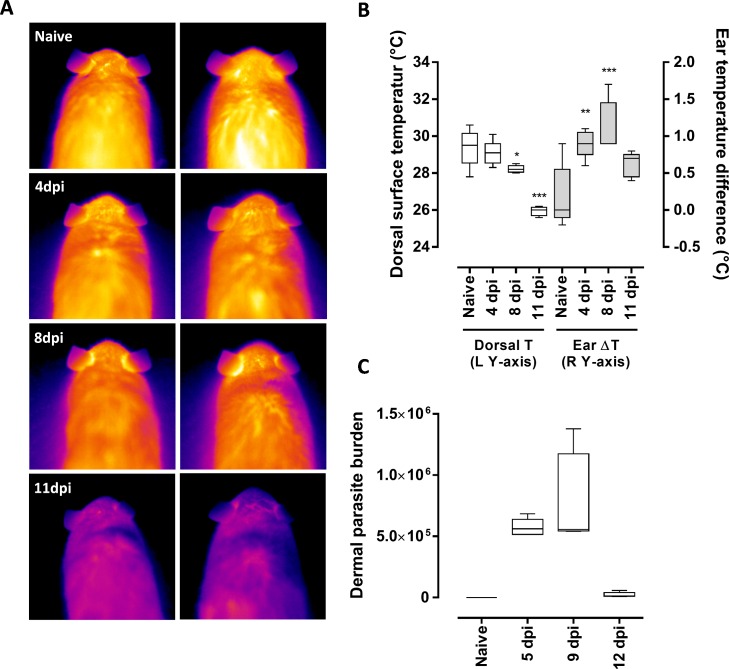
Thermographic analysis of the dermal site of parasite expansion.(A) High resolution thermographic images of 2 representative naive mice and mice at 4, 8 and 11dpi following initiation of a T.b.brucei AnTAR1 infection by an SG+ tsetse fly bite on the left ears (n = 5 for each time point). Right ears were not exposed and served as controls. Images are presented with identical thermal scales. Data are representative of two independent experiments (B) Box plot graph with the measured dorsal temperatures (plotted on left Y-axis) and the temperature differences between exposed and non-exposed ears (plotted on the right Y-axis; n = 5 for each group and time point). (C) Evolution of the density of parasites in the dermis of the ear determined by SL-RNA specific RT-qPCR of the mice used for thermographic imaging (n = 5 for each group and time point). Box plots are with whiskers extending from minimum to maximum. *: P < 0.05, **: P < 0.01; ***: P < 0.001